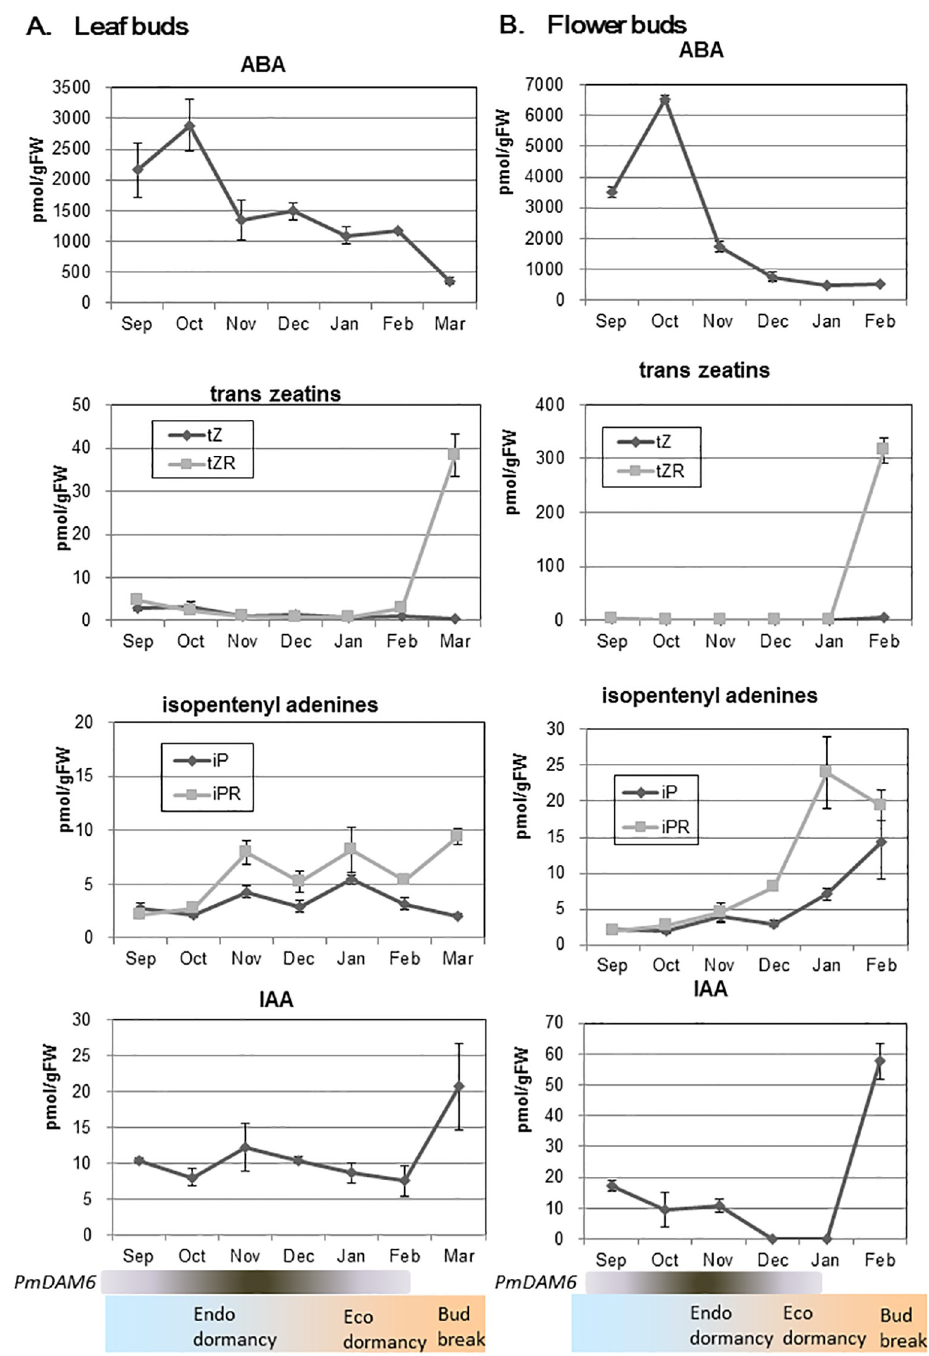
Fig 7. Seasonal changes in the phytohormone contents of dormant Japanese apricot ‘Nanko’ buds. The PmDAM6 expression levels and dormancy status are briefly described at the bottom based on the previous studies. Values are presented as the mean of three replicates. Bars indicate standard